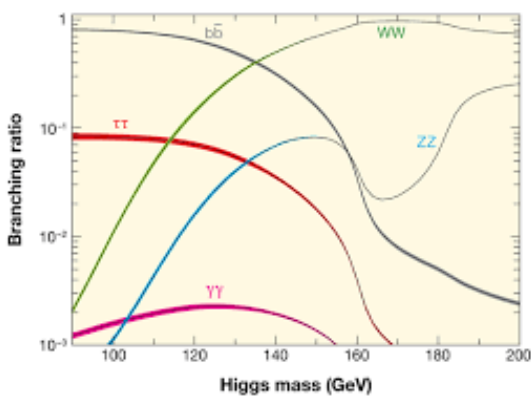
Figure 5. The Standard Model Higgs boson decay branching